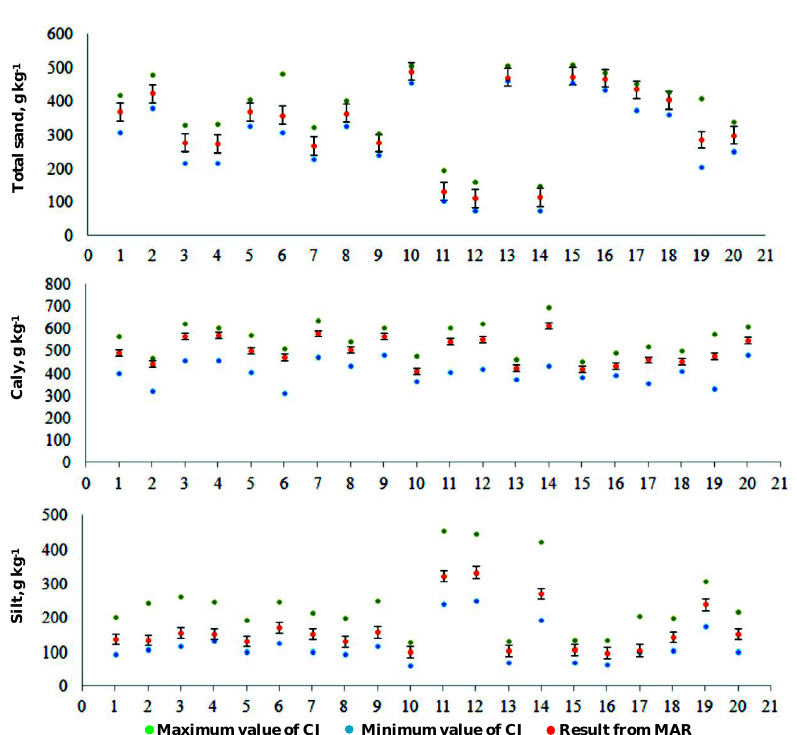
Figure 4. Accuracy analysis for 21 Clayey soil samples: representation of the minimum and maximum values of the confidence intervals (CI), means and average standard errors (bars) for total sand, silt and clay contents as determined by particle-size analysis using the reciprocal shaker